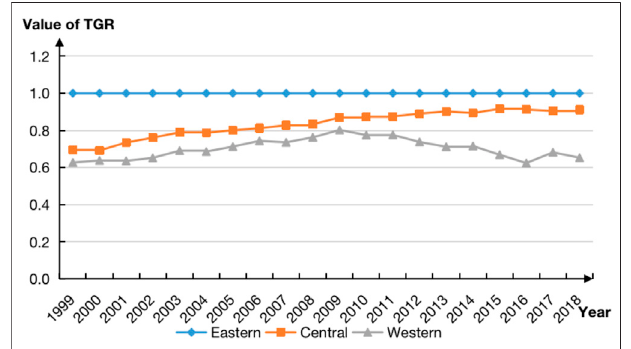
FIGURE 2 | Analysis of the technology gap ratio (TGR) of innovation ef fi ciency in each